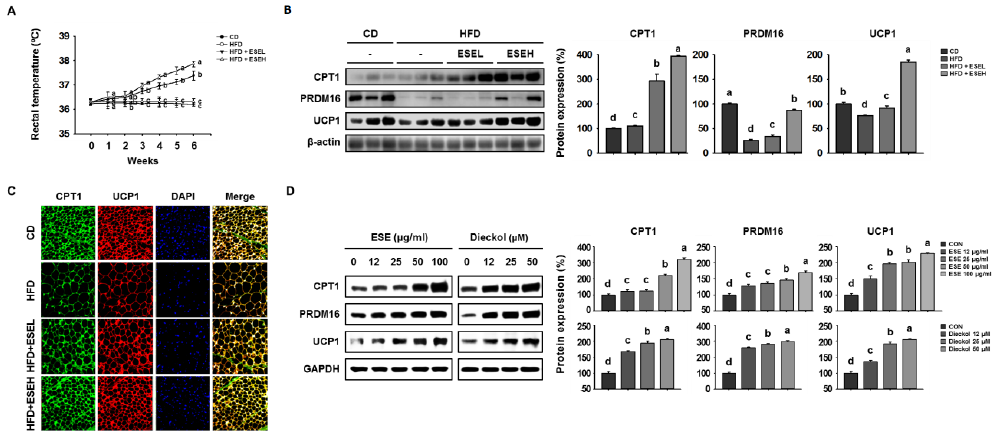
Figure 5. Effects of ESE on thermogenesis and the expression of proteins involved in browning in the WAT of HFD-fed mice and 3T3-L1 cells. ( A ) Rectal temperatures during 6 weeks of ESE treatment. ( B ) Western blots of proteins involved in browning (carnitine palmitoyltransferase 1 (CPT1), PR domain-containing 16 (PRDM16), and uncoupling protein 1 (UCP1)) in WAT. ( C ) Immunofluorescence images of WAT (200 × magnification). ( D ) Western blots of proteins involved in browning in 3T3-L1 cells. Data are expressed as means ± SDs ( n = 4). Values with di ff erent letters are significantly di ff erent: p < 0.05 (a > b > c > d).